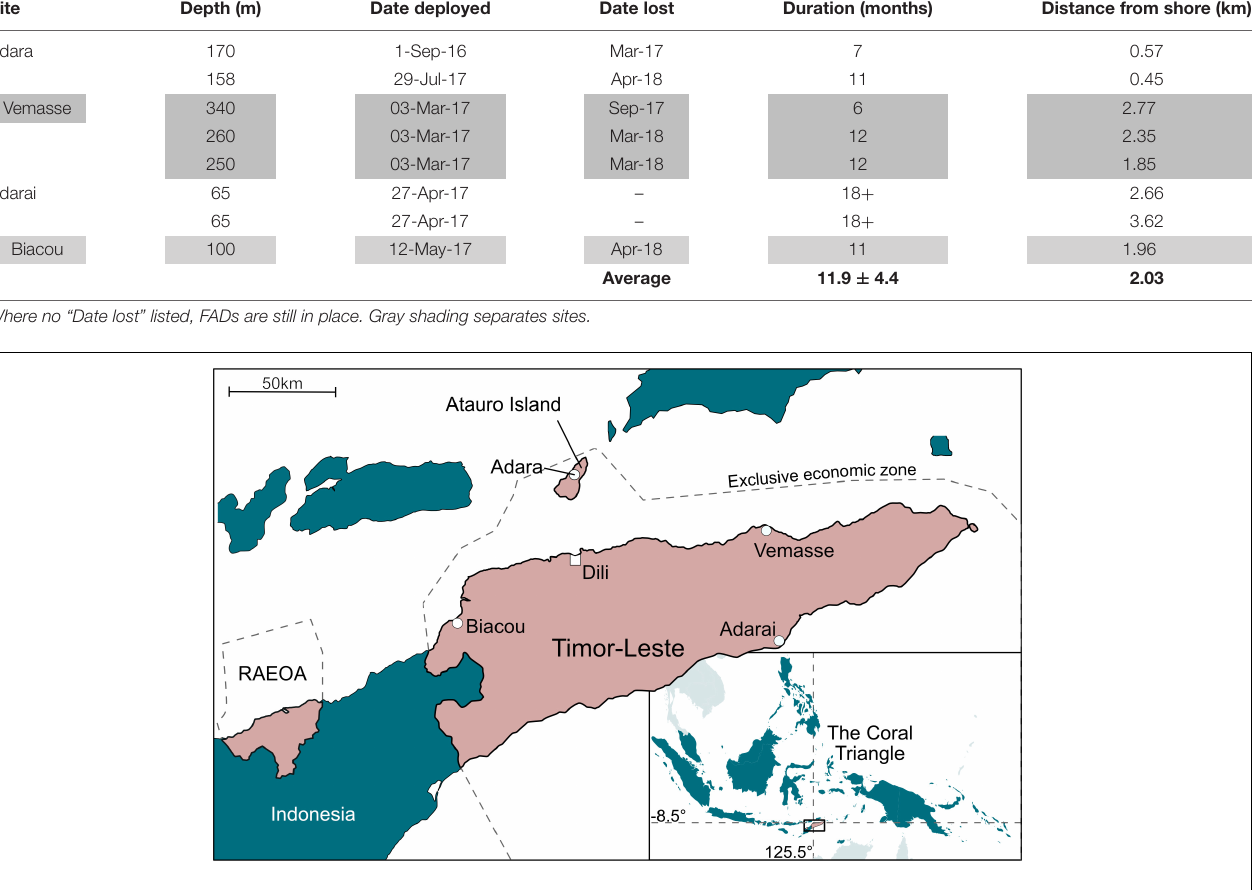
FIGURE 1 | Location of Timor-Leste with the Coral Triangle (inset), and the location of four study sites for testing nearshore FAD deployments. Dotted lines represent the Exclusive Economic Zone of Timor-Leste. The RAEOA is the Special Administrative Region of Oecusse-Ambeno. (Adapted from Tilley et al., 2019. Map created using a vector layer adapted from FreeVectorMaps.com©Striped Candy